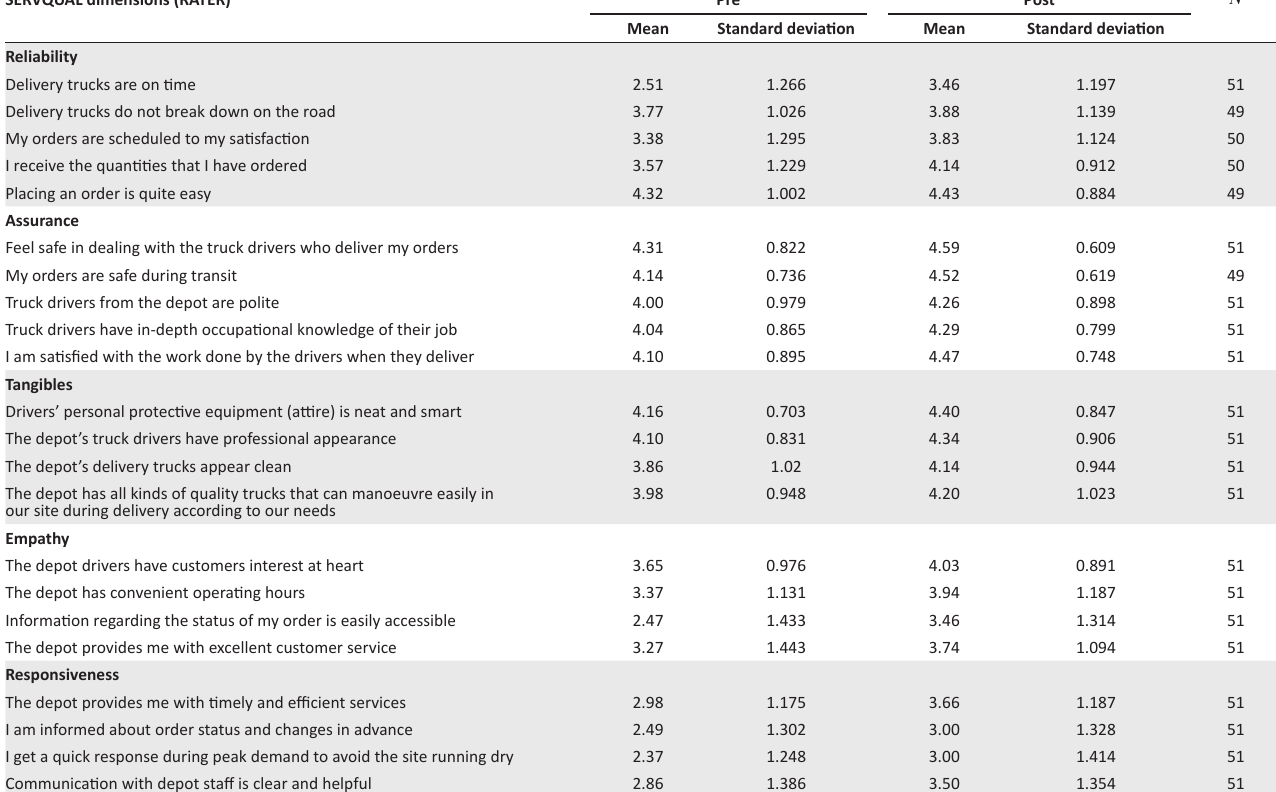
TABLE 6: Depot service quality scores: Customers’ perceptions of service quality (pre and post) key performance indicators implementation. SERVQUAL dimensions